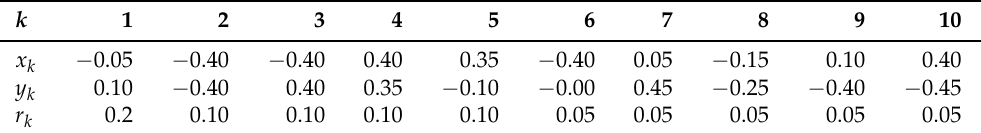
0,0.2,0.5,1.0,1.2,5.0 . ∈ { } 10 − 4 , α = 10 − 2 , β = 10 − 5 , × [ 0.6, + 0.6 ] 0.6, + 0.6 ] − × −